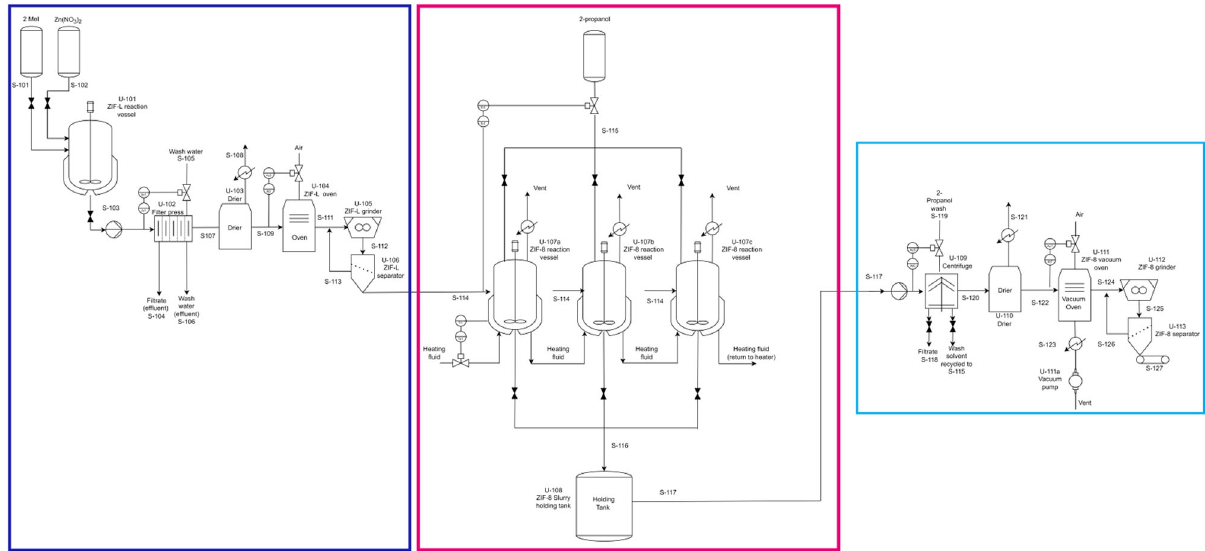
Fig. 11 A proposed fl ow sheet. Proposed process fl ow concept diagram for nano ZIF-8 production. The dark blue box indicates the ZIF-L synthesis node, the pink box indicates the ZIF-L to ZIF-8 transformation node and the light blue box indicates the fi nal nano ZIF-8 processing